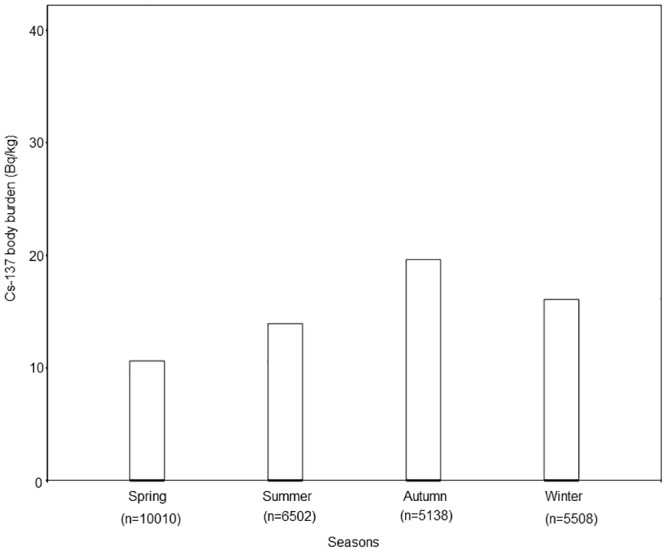
Seasonal difference of Cs-137 body burden in residents.The end of the box indicate the positions of the 75th percentiles of the data. The median Cs-137 body burden was below the detectable level in each season however significantly higher in autumn than other seasons (p<0.001).